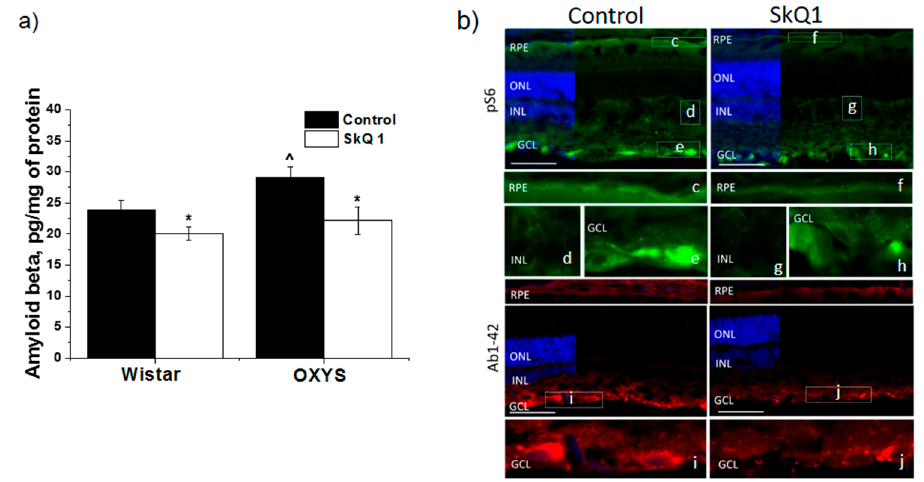
Figure 5. The e ff ect SkQ1 (250 nmol / [kg of body weight] per day from the age of 1.5 to 22 months) on the A β and p-S6 protein in the retina of OXYS rats and Wistar. Immunoassay revealed decrease A β 1-42 protein content in the retina of OXYS rats and Wistar rats treated with SkQ1 ( a ). * p < 0.05: a statistically significant e ff ect of SkQ1; ˆ p < 0.05: a di ff erence between OXYS and Wistar rats (mean ± SE). Representative images of retinal cryosections immunostained for p-S6 and A β 1–42 and enlarged images from insets in RPE, INL and GCL ( b ). Immunostaining for p-S6 (green) uncovered a decrease in the intensity of p-S6-positive cells in the retina of OXYS rats treated with SkQ1. SkQ1 treatment also reduced the A β 1–42 (red) immunoreactivity in the retina of OXYS rats. Cell nuclei were stained with DAPI. RPE: Retinal pigment epithelium, ONL: Outer nuclear layer, INL: Inner nuclear layer, GCL: Ganglion cell layer. The scale bar is 50 µm.